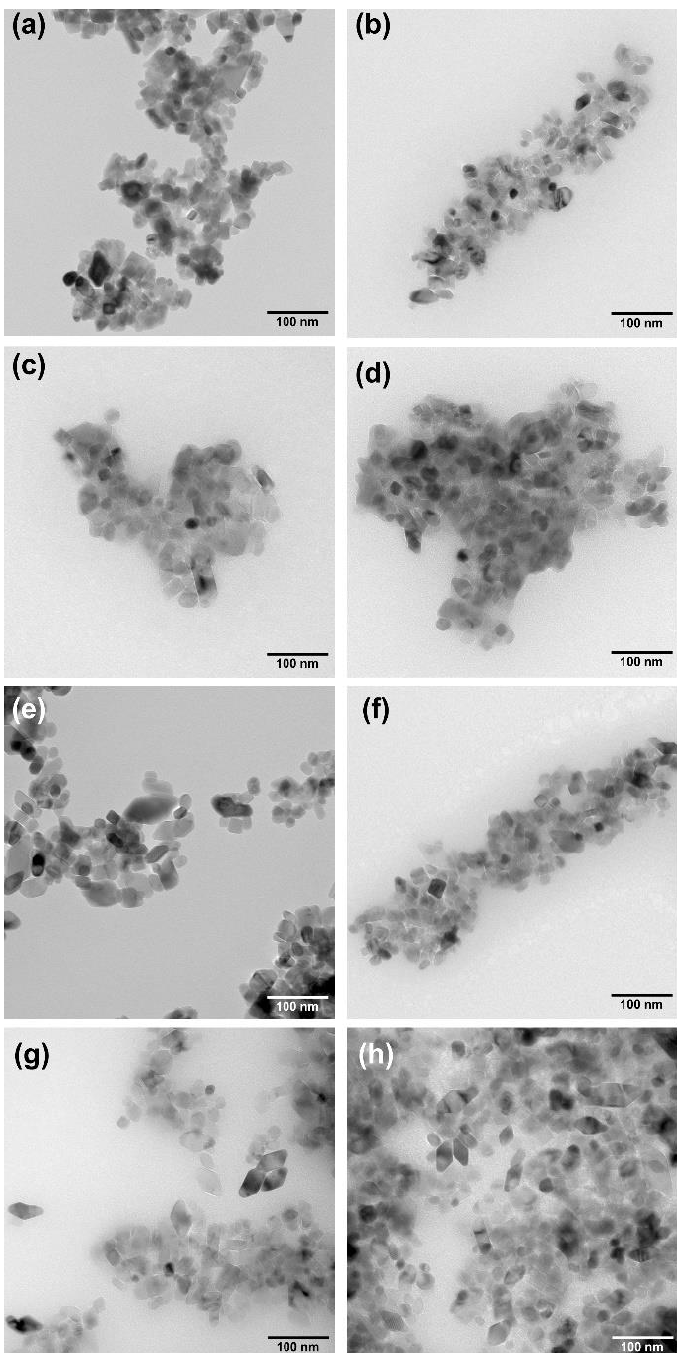
Figure 6. The results of TEM analysis for: TiO 2 -0.5%Eu ( a ), TiO 2 -0.75%Eu ( b ), TiO 2 -1%Eu ( c ), TiO 2 -1.5%Eu ( d ), TiO 2 -0.5%La ( e ), TiO 2 -0.75%La ( f ), TiO 2 -1%La ( g ), and TiO 2 -1.5%La ( h ). EDS mapping was performed to determine the distribution of lanthanum and eu- ropium particles on the surface of the base material (TiO 2 ) for selected materials. The results of the above analysis are presented in Figure